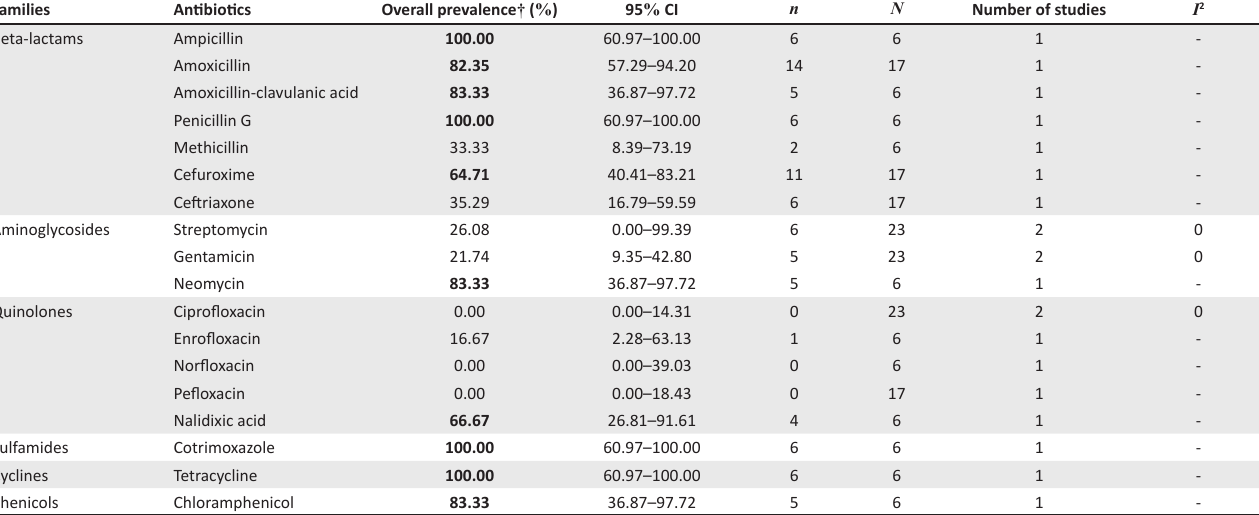
TABLE 7: The overall prevalence of antibiotic resistant coagulase negative Staphylococcus strains isolated from dogs in Africa. Families